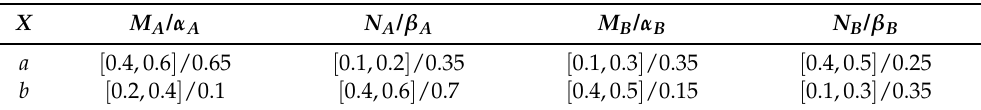
Table 1. CISs A and B